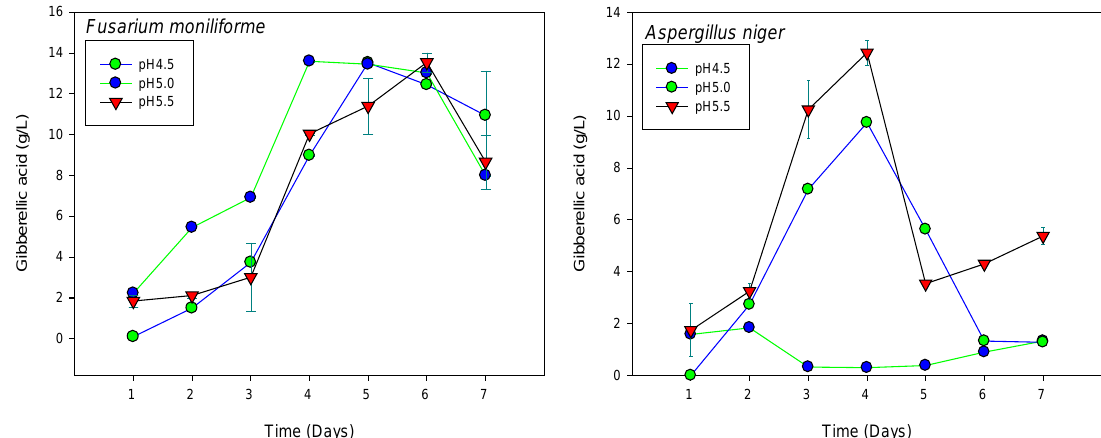
Fig. 2. Effect of varying pH on gibberellic acid yield using F. moniliforme and A. niger grown on banana peel as substrate